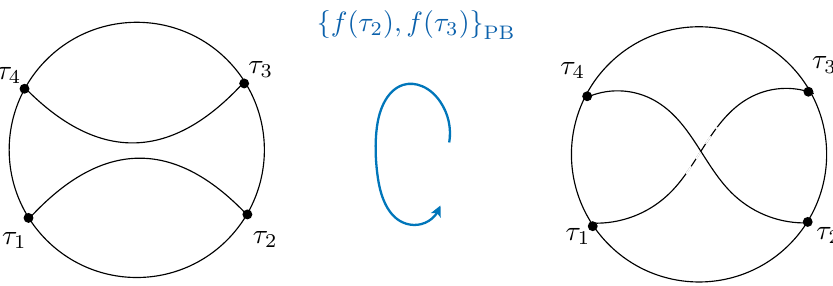
Figure 4. Illustration of our computation of the semiclassical OTO by saddle point. In order to get the operator in OTO order as shown, we must twist two of the insertions around each other. Quantum mechanically this corresponds to the ‘second-sheet’ analytic continuation from Euclidean to Lorentzian times and is equivalent to the insertion of a commutator [ f ( (cid:27) 1 ) ; f ( (cid:27) 2 )] when writing the operators in terms of integrals over the Goldstone mode f . This commutator can be computed semiclassically using the AS symplectic form to generate the Poisson bracket on the appropriate Virasoro coadjoint orbit (Details in section